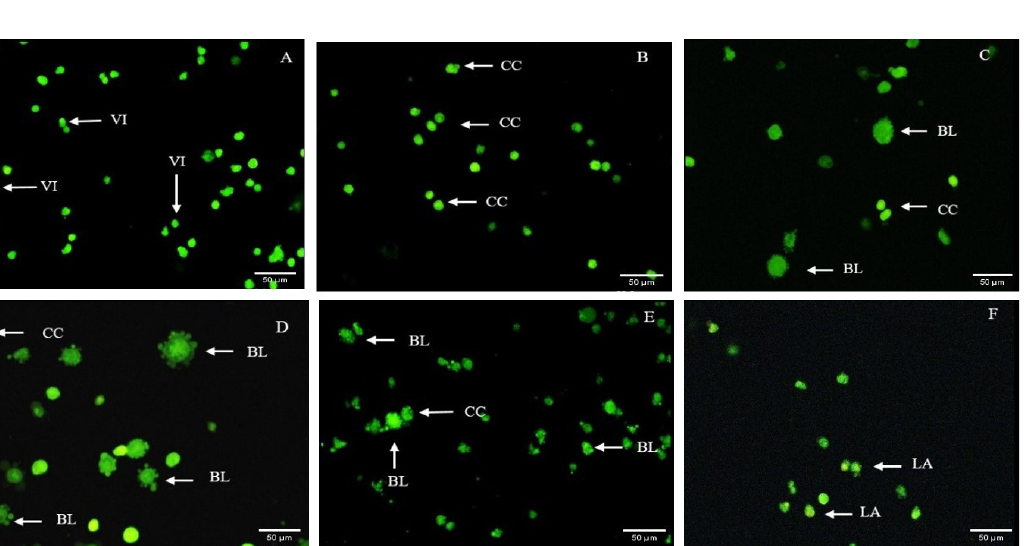
Figure 9. Fluorescence microscope AO/PI double staining of HRBE fractions on SW-620 cells after being treated with 0 mg/mL, considered as negative control ( A ), 2.5 mg/mL ( B ), 5 mg/mL ( C ) and 10 mg/mL ( D ) for 72 h compared to positive control groups treated with 0.05 mg/mL mitomycin C treatment ( E ) and doxorubicin 0.116 mg/mL ( F ). VI: viable cell; blebbing of the cell membrane; CC: chromatin condensation; LA: late apoptosis.